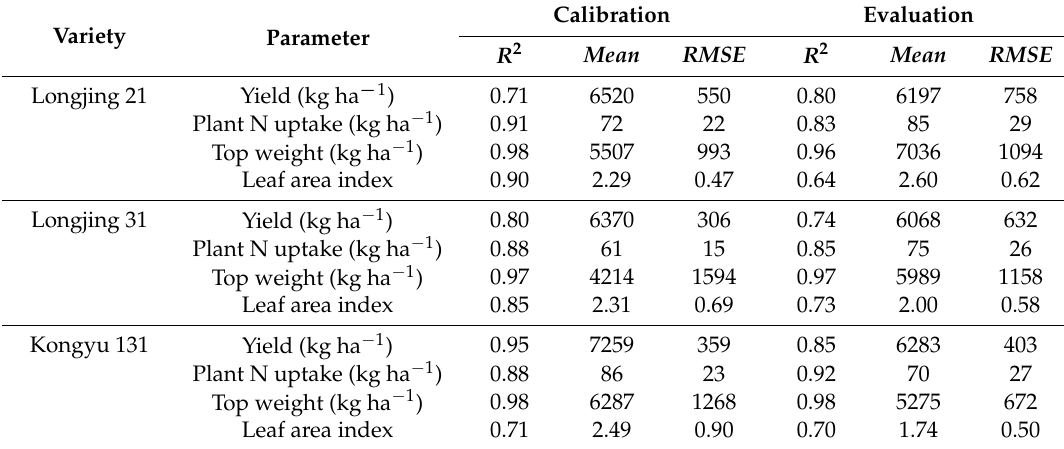
Table 2. Summary of CERES-Rice calibration and evaluation of three varieties, including four variables (yield, plant N uptake, top weight, LAI) with the experimental data during 2011–2016.